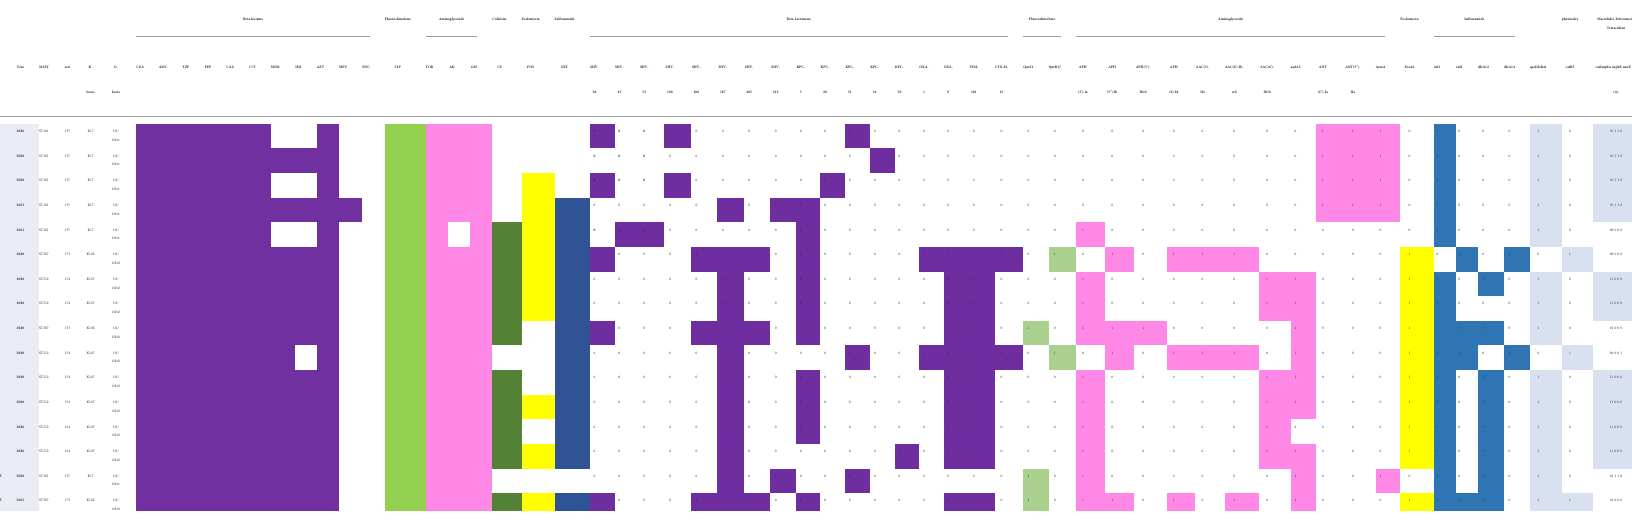
TABLE 2 Resistance pro fi le and gene